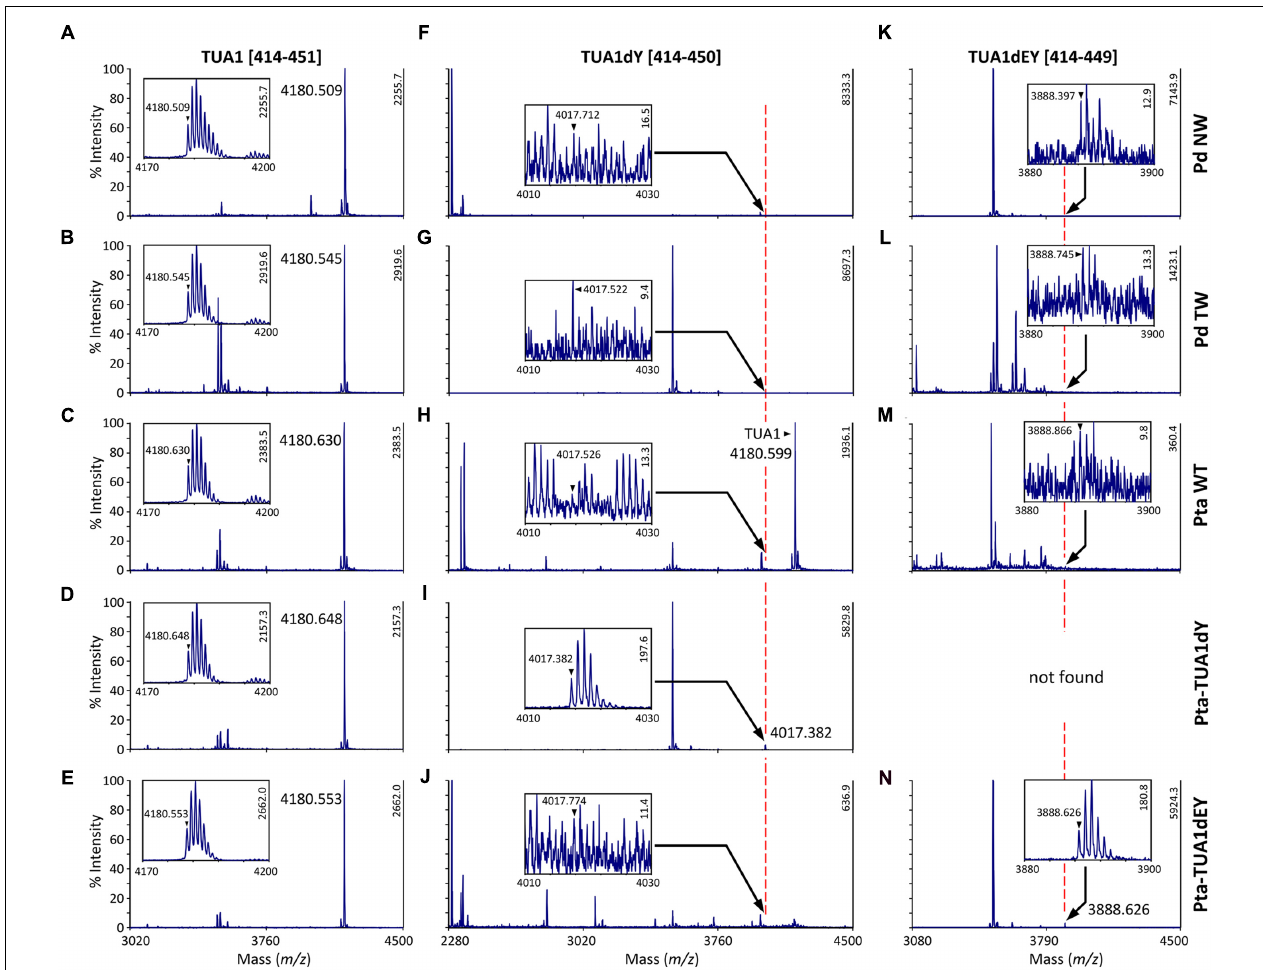
FIGURE 3 | MS analysis of TUA detyrosination and non-tyrosination. Mass spectra of the C-terminal CNBr peptides of TUA1 (A–E) , its detyrosinated (TUA1dY, F–J ) or non-tyrosinated (TUA1dEY, K–N ) isoforms. The primary axis is scaled to the most abundant peptide in each panel, with intensity on the secondary axis. Insets show mass spectra of the respective C-terminal peptide. The monoisotopic mass is denoted by a triangle. Insets in (A–E,I,N) show consistent isotopic profiles. The peptide identities in (C,I,N) were previously confirmed by MALDI-TOF/TOF (Swamy et al., 2015). Peptide signals in all other insets (F–H,J–M) lacked clear isotopic distribution and are deemed background